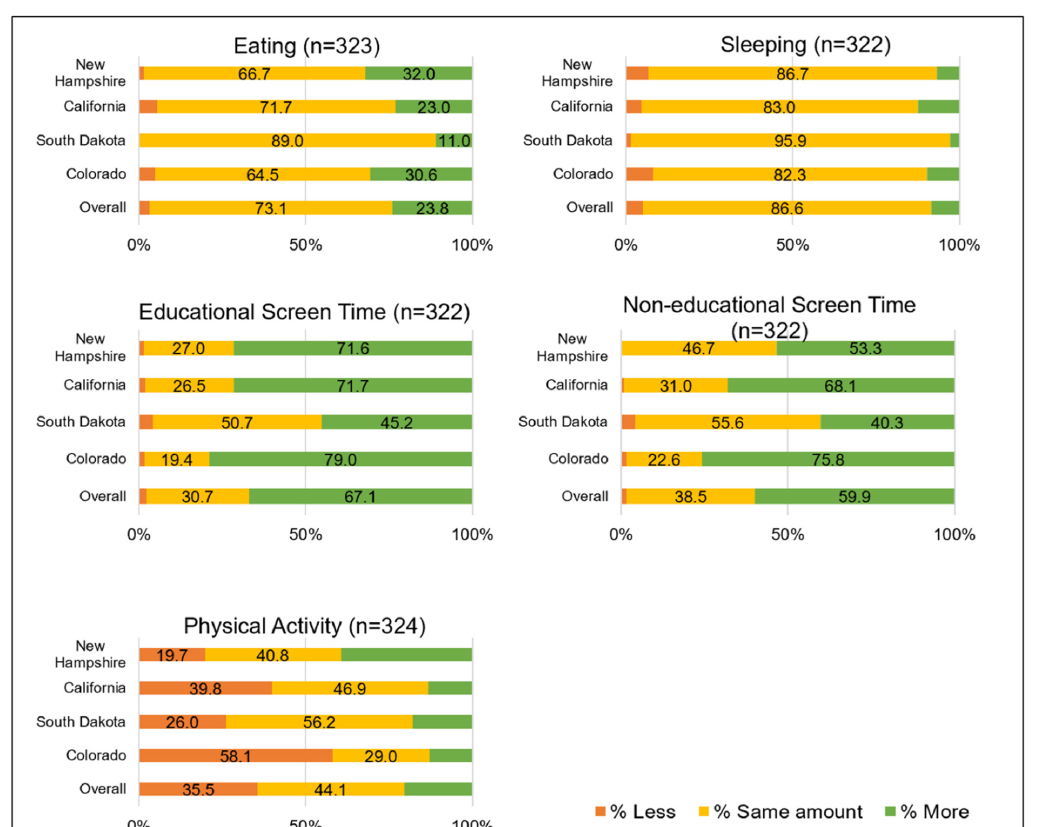
= 0.154), and sleep duration ( p = 0.086). Table 2. Change in health behaviors between pre-pandemic and pandemic among children ages 4– 12 years in the 4 cohorts participating in the Environmental influences on Child Health Outcomes Program ( n = 347). Outcomes